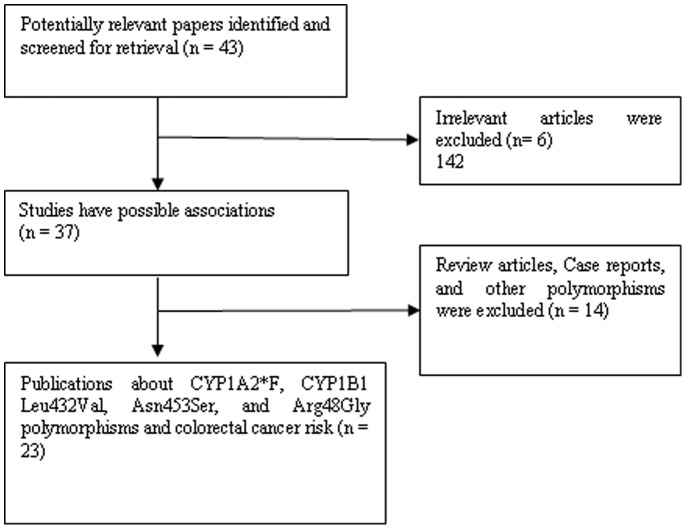
Study flow chart explaining the selection of the 23 eligible articles included in the meta-analysis.